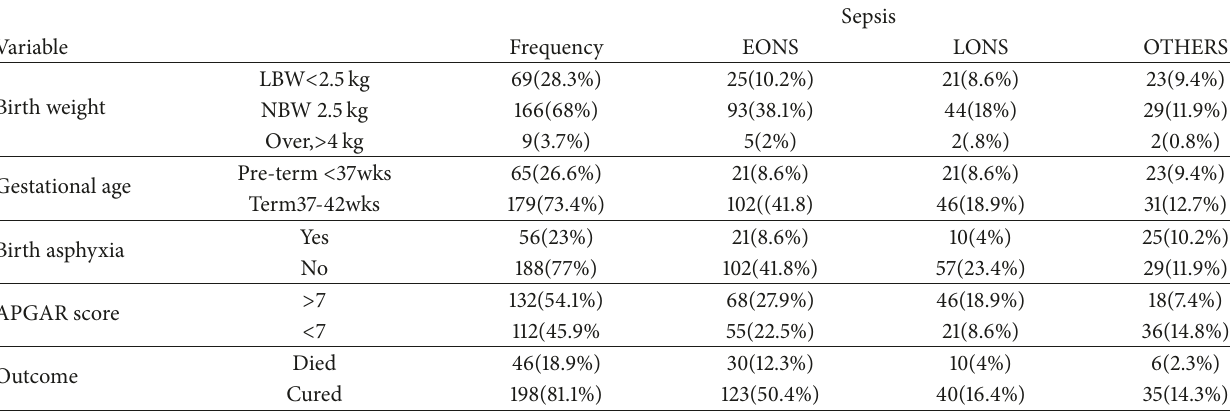
Table 3: Birth related factors predisposing a neonate for neonatal sepsis among neonates admitted in Shashemenne referral hospital and Melka Oda district hospital in NICU wards, Ethiopia, 2017.